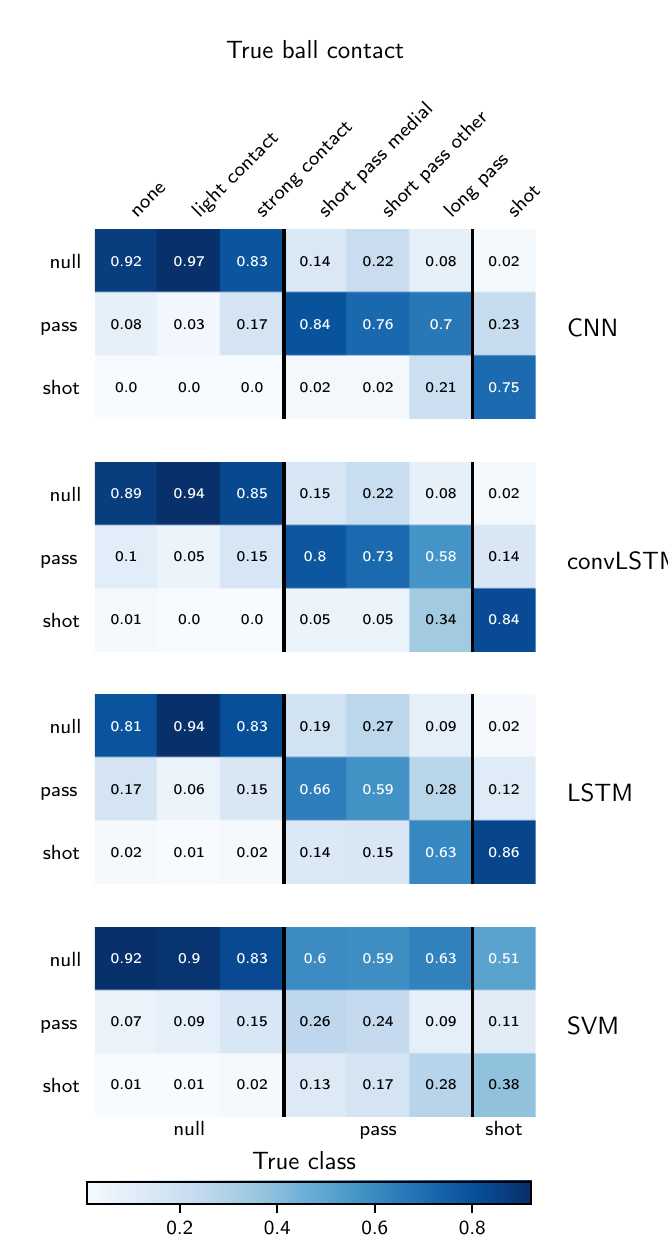
Figure 5. Classification performance of all models for the window_lab evaluation using a moving window and candidate selection on laboratory data. A detailed explanation of the way of presentation can be found in Section 3.7. True and predicted classes are given on the bottom and left, respectively. Finer grained true ball contacts are shown on top. The given values are normalized over the true ball contact labels. Thus, the greatest possible value is one, the smallest possible value is